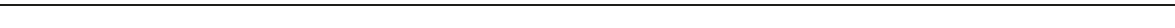
Fig. 4 Expression analyses. a – f In situ RNA hybridization of VRS3 in two-rowed barley cv . Bowman at lemma primordium (LP) (spike length 2 mm) and awn primordium (AP) stage (spike length 5 mm). a – c Longitudinal sections hybridised with antisense VRS3 probe ( a ) at LP stage showing VRS3 signal in the developing glumes (gl) of the lateral spikelet (ls, in middle plane) and potential signal (*) from the glume of the adjacent central spikelet (CS) and at ( b ) AP stage showing expression in the rachis (r, yellow arrowheads) and ( c ) at higher magni fi cation. d – f Equivalent longitudinal sections hybridised with sense probe. Scale bars, 100 µ m ( a , b ), 200 µ m ( c , d ), 50 µ m ( e , f ). g Heat map of differentially expressed (DE) genes implicated in regulating spike development and meristem identity. Legend indicates gene expression abundances ( Z scores) across the different developmental stages AP (5 mm) and white anther (WA) (10 mm) in BW902( vrs3 .f) and Bowman ( n = 8 bioreps per genotype). h Venn diagram showing the overlap of DE genes between Bowman (WT) and BW902( vrs3 .f) in AP (5 mm) and WA (10 mm) spikes. Numbers represent the DE genes genetically located outside of the vrs3 .f introgression in BW902( vrs3 .f). i – m Average gene transcript levels determined by quantitative RT-PCR in Bowman WT (black) and BW902( vrs3 .f) (red) in AP and WA spikes; i VRS1; j VRS2 ; k VRS3 ; l VRS4 ; m VRS5 . HvActin was used for normalization. x -axis shows the in fl orescence developmental stages in which the